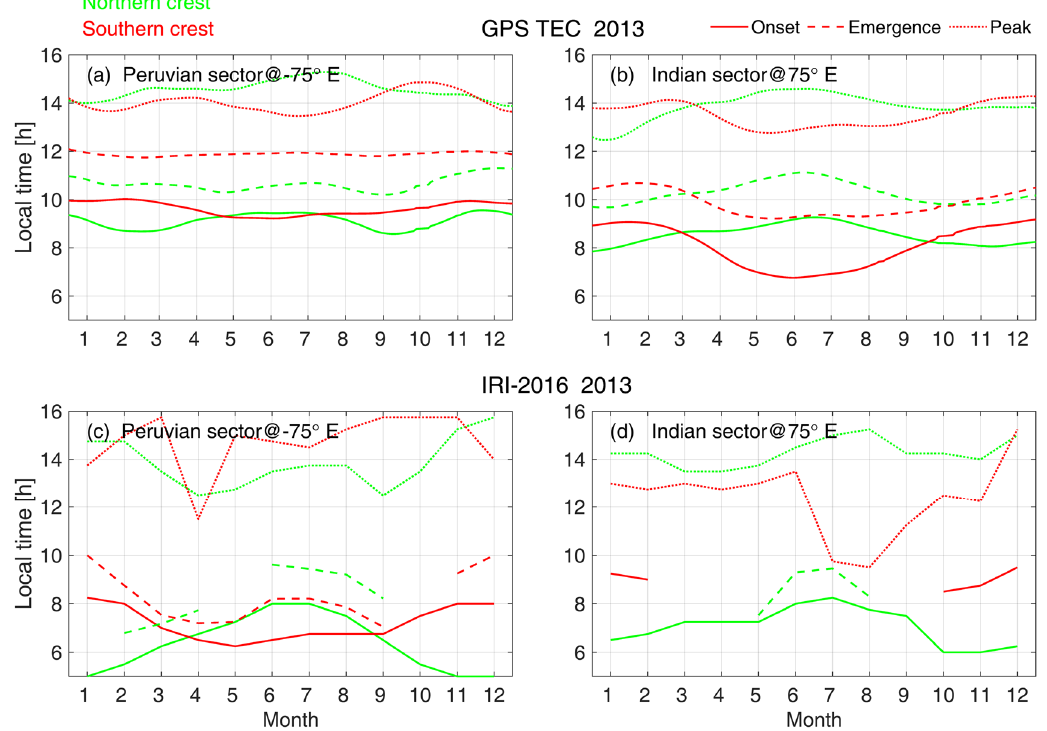
Figure 6. Local time of the onsets (solid lines), emergence (dash lines), peaks (dotted lines) of the EIA northern crest (green) and southern crest (red), at Peruvian ( a – c ) and Indian sector ( b – d ), extracted from GPS TEC (top panels) and IRI-2016 (bottom panels). The data gap in Figure 6c,d is due to that the time points sometimes cannot be identified in the IRI model.